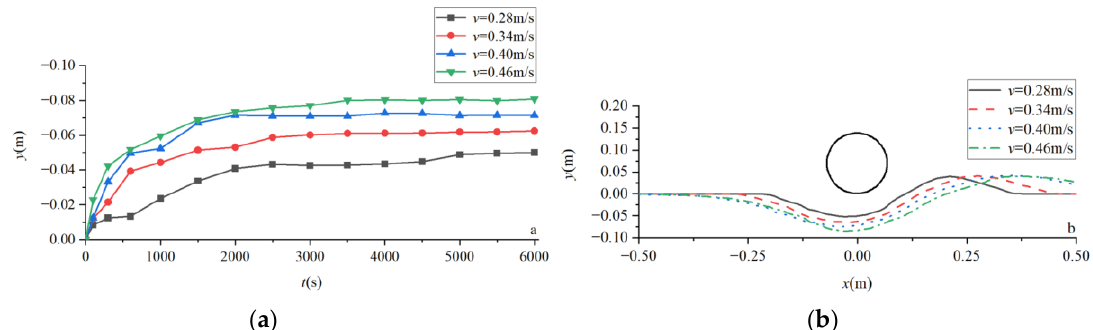
Figure 8. Comparison of scour depth and terrain under the pipeline at various velocities. ( a ) The scour depth and ( b ) The scour terrain.